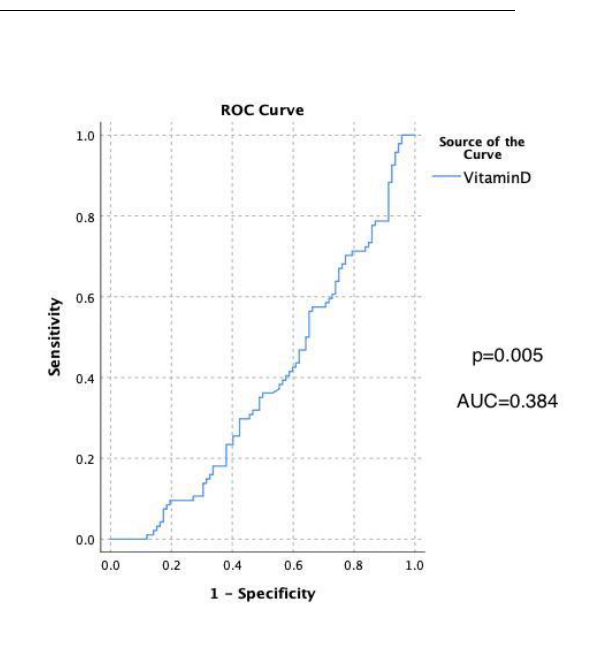
Fig. 1. ROC analysis result of serum vitamin D